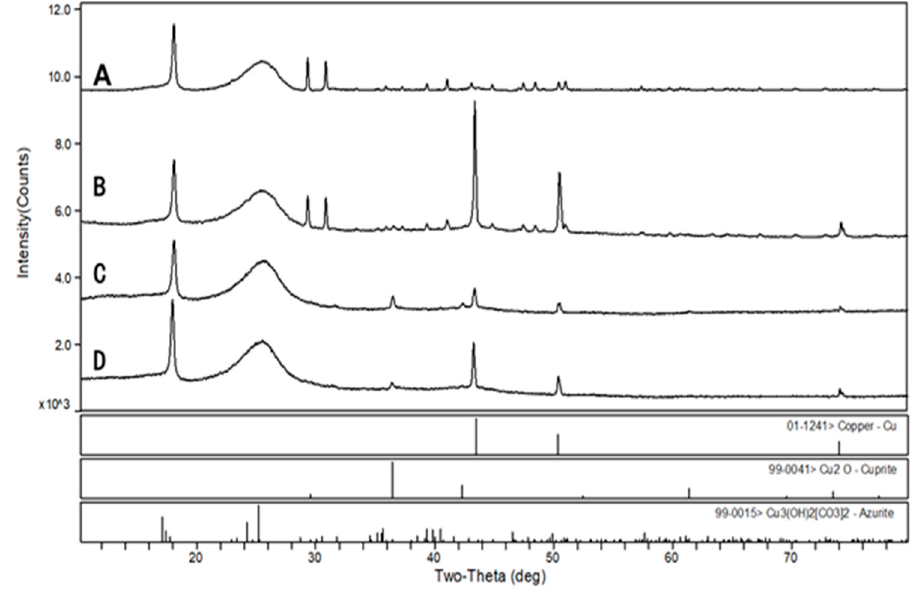
Figure 9. Physical phase analysis of MFCs cathode surface deposits after treatment of simulated AMD. ( A ): abiotic, ( B ): pH = 6.0, ( C ): pH = 5.0, and ( D ): pH = 4.0.